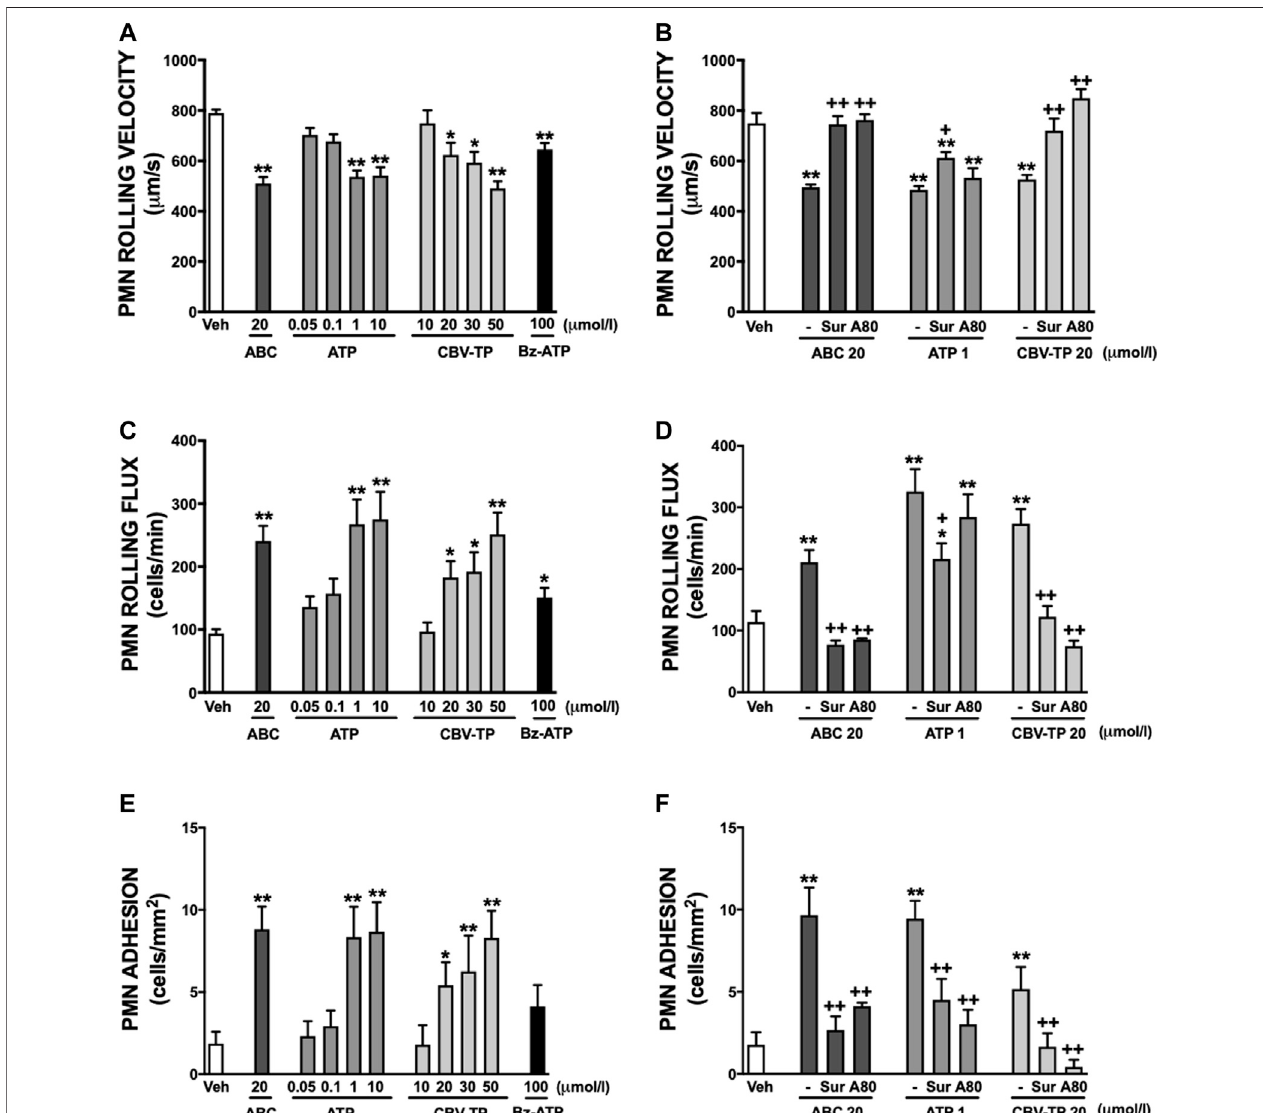
FIGURE 2 | PMN-endothelial cell interactions. HUVEC and PMN were incubated (4 h) with ABC (20 µmol/L), ATP (0.05 – 10 µmol/L), CBV-TP (10 – 50 µmol/L), Bz- ATP (100 µmol/L) or vehicle (veh). In some cases, both cell types (HUVEC and PMN) were pretreated with suramin (Sur, non-selective P2R antagonist, 100 μ mol/L, 60 min) or with A804598 (A80, P2X7R antagonist, 1 μ mol/L, 30 min) prior to ABC (20 µmol/L), ATP (1 µmol/L) or CBV-TP (20 µmol/L). PMN rolling velocity (A, B) , PMN rolling fl ux (C, D) and PMN adhesion (E, F) were quanti fi ed. Results are mean ± SEM, Veh: n ≥ 14, ABC: n ≥ 7, ATP 0.05: n ≥ 4,ATP 0.1: n ≥ 13,ATP 1: n ≥ 6, ATP 10: n ≥ 6, CBV-TP 10: n ≥ 6,CBV-TP 20: n ≥ 5,CBV-TP 30: n ≥ 5, CBV-TP 50: n ≥ 6,Bz-ATP 100: n ≥ 6,ABC20 +Sur: n ≥ 4,ABC 20+A80: n ≥ 4,ATP 1+Sur: n ≥ 6, ATP 1 +A80: n ≥ 5, CBV-TP 20 +Sur: n ≥ 5, CBV-TP 20 +A80: n ≥ 5. * p < 0.05 or ** p < 0.01 vs. corresponding value invehicle-treated group. + p < 0.05 or ++ p < 0.01 vs. corresponding value in ABC, ATP or CBV-TP-treated group (ANOVA followed by Newman-Keuls test).